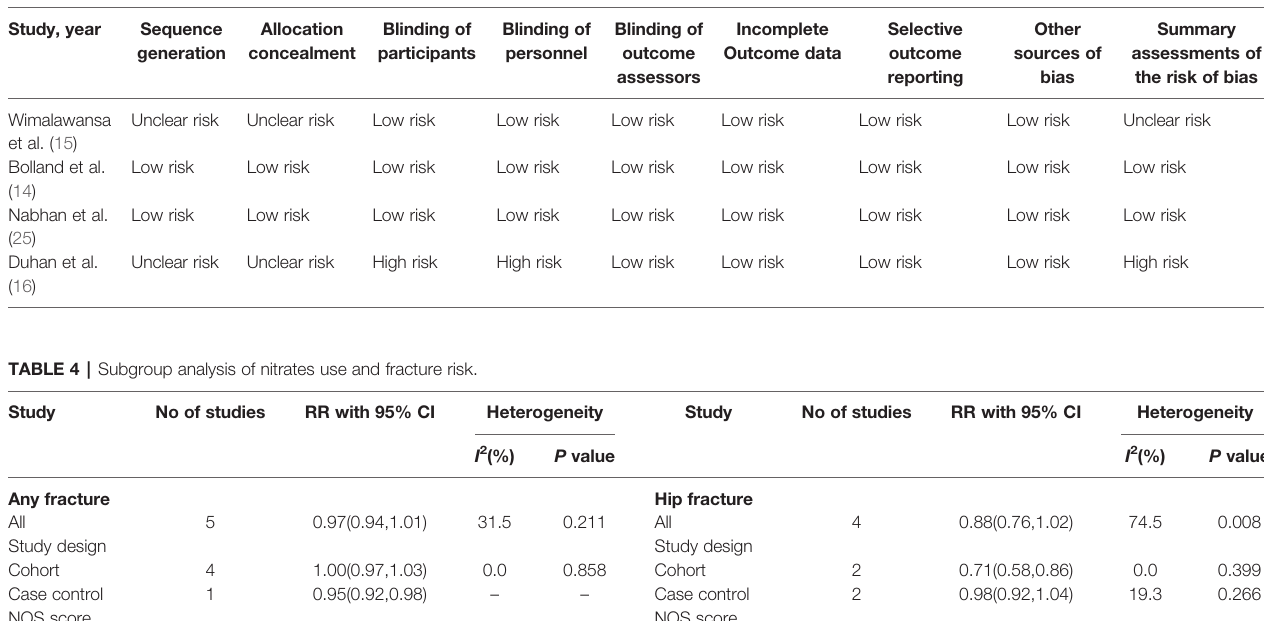
TABLE 3 | Risk of bias of randomized controlled trials evaluating the ef fi cacy of nitrates for bone health.